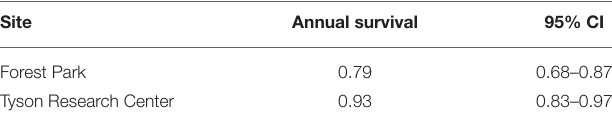
TABLE 2 | Best fit model [S (site)] estimated annual survival probabilities of VHF-tagged three-toed box turtles in Forest Park (urban) and Tyson Research Center (rural) in Missouri, March 2012–February